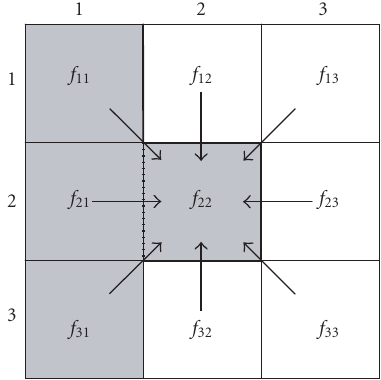
Figure 2: HCT applied to a 3 × 3 image. In the case that pixel f 22 indicates a true uptake (gray), the solid line is the true border and HCT algorithm iteratively averages its value with the pixels in the first column. In the case that dotted line is the true border, the up- take in pixel f 22 iteratively averages its value with the pixels in the second and third